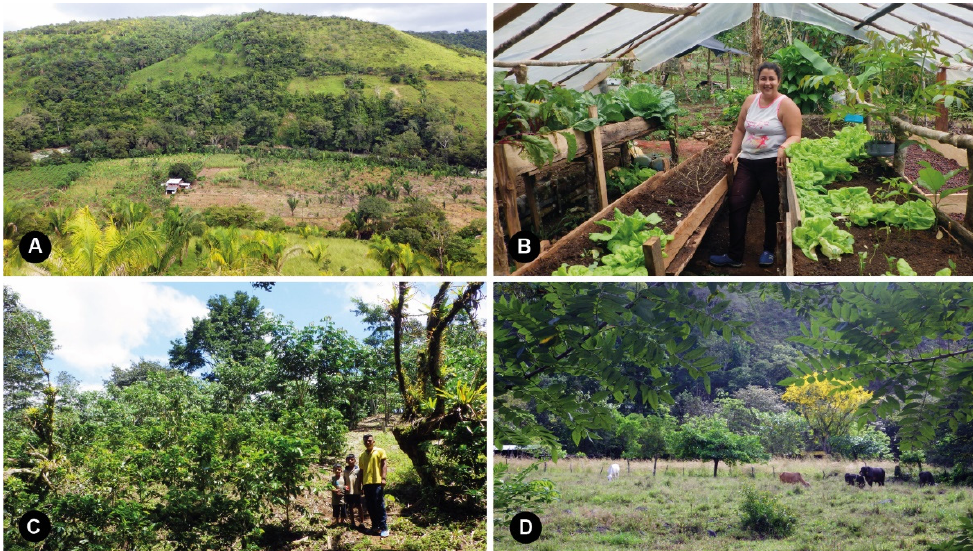
Figure 2. Peasant and indigenous family farms. ( A ) View of a peasant farm; ( B ) Detail of a peasant family’s vegetable garden; ( C ) Coffee growing in silviculture and polyculture in the indigenous territory of Cabagra; ( D ) Silvopastoral system with a predominance of shrub species in a peasant farm. Source: authors’ own images.